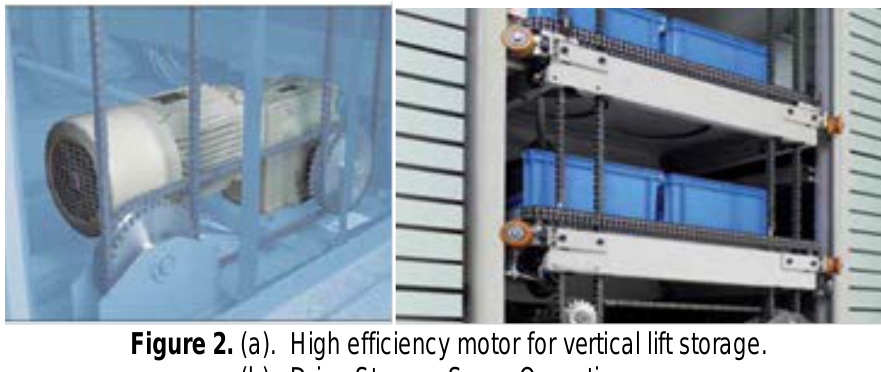
Figure 2. (a). High efficiency motor for vertical lift storage. (b). Drive Storage Saver